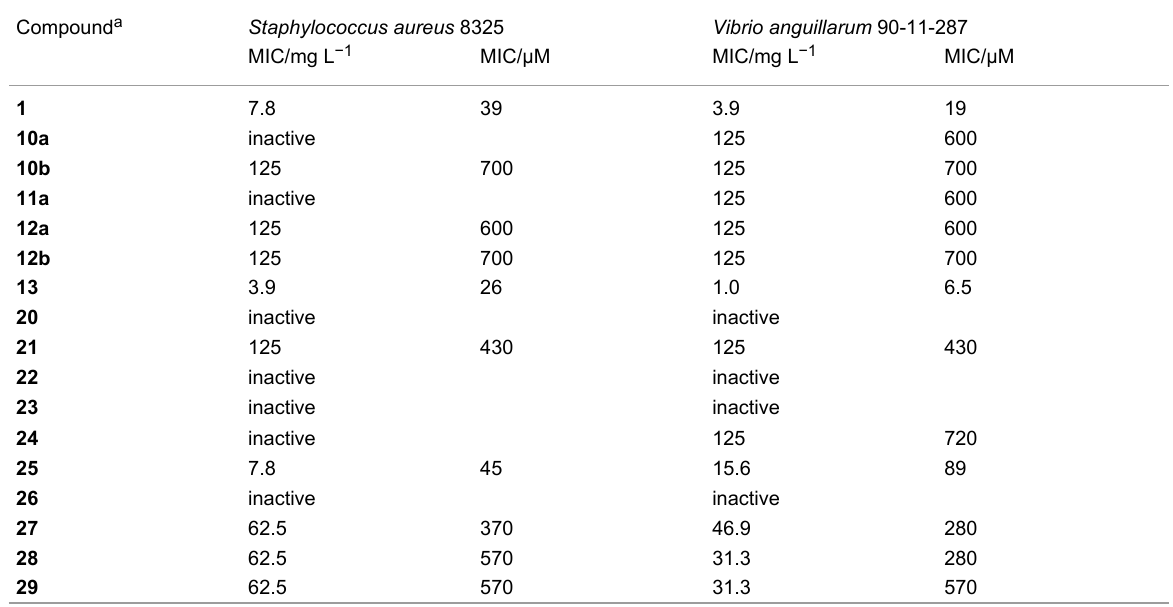
Table 1: Bioactivity tests with TDA and TDA